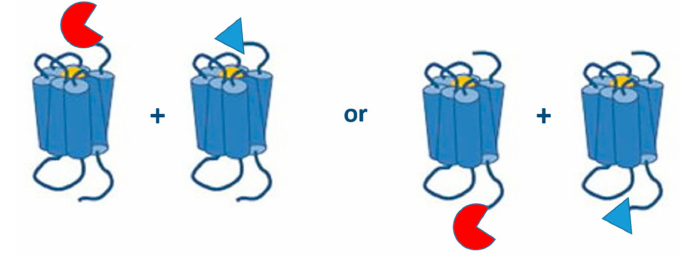
Figure 6. N- or C-terminally split biosensor